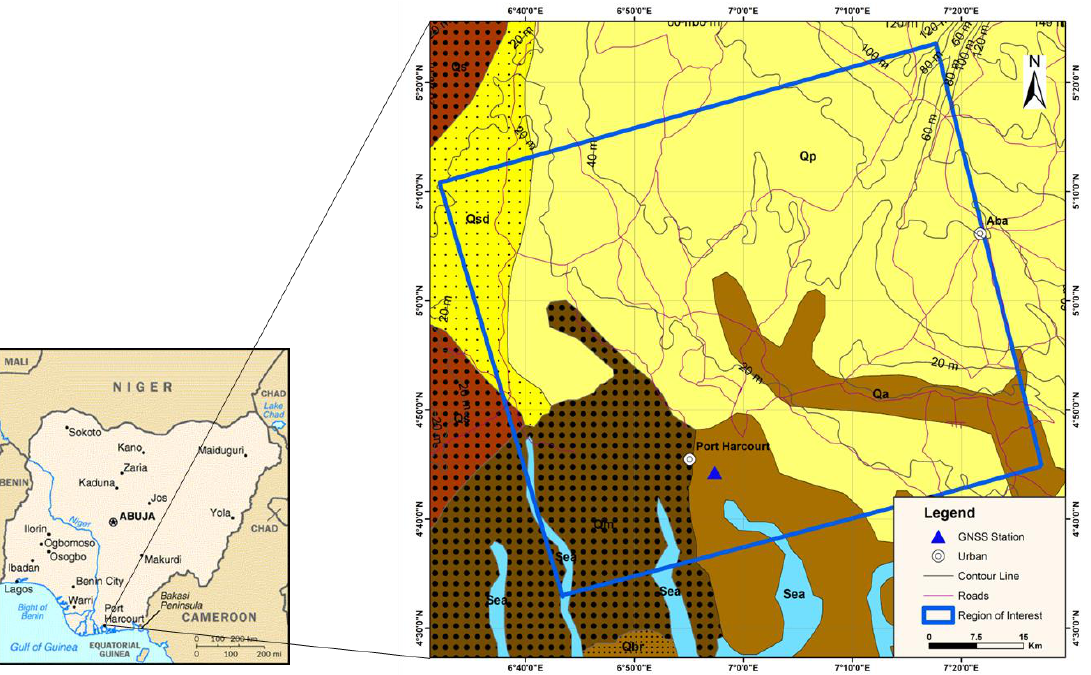
Figure 1. Geological map of Nigeria, showing the basement complex, sedimentary basins, and the study location (Port Harcourt). Tm, Paleocene Imo Formation; Tb, Ameki Group; Tl, Og washi Asaba Formation; and Qp, Benin Formation.